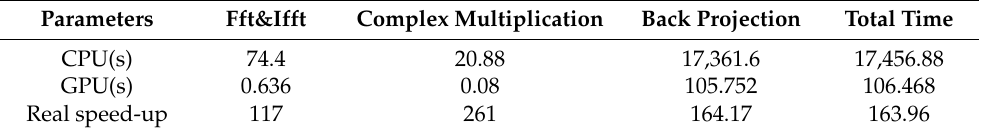
Table 2. Comparison of processing